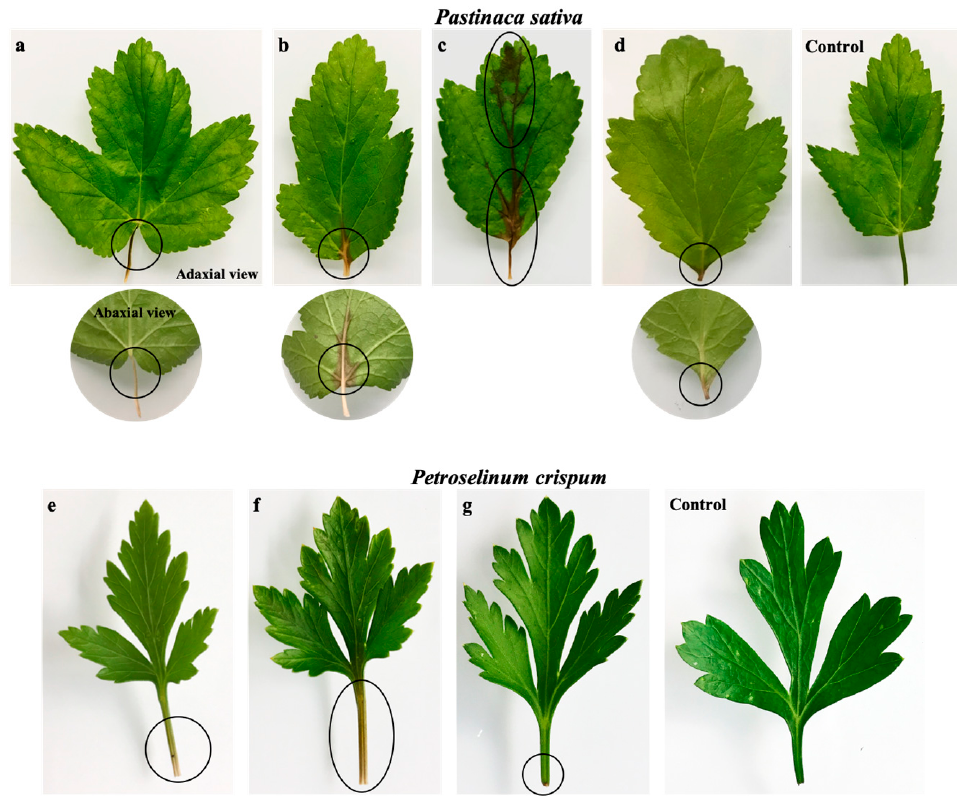
Figure 3. Leaf immersion assay. Phytotoxic damage of α -acetylorcinol ( 1 ) and p -hydroxybenzoic acid ( 2 ) on leaves excised from parsnip ( P. sativa ) and parsley ( P. crispum ) plants: ( a ) p -hydroxybenzoic acid (7.25 mM), ( b ) p -hydroxybenzoic acid (14.5 mM), ( c ) p -hydroxybenzoic acid (22.0 mM), ( d ) α -acetylorcinol (22.0 mM), ( e ) p -hydroxybenzoic acid (14.5 mM), ( f ) p -hydroxybenzoic acid (22.0 mM), and ( g ) α -acetylorcinol (22.0 mM). The sterile uninoculated medium was used as a control. The circle indicates the phytotoxic effect.